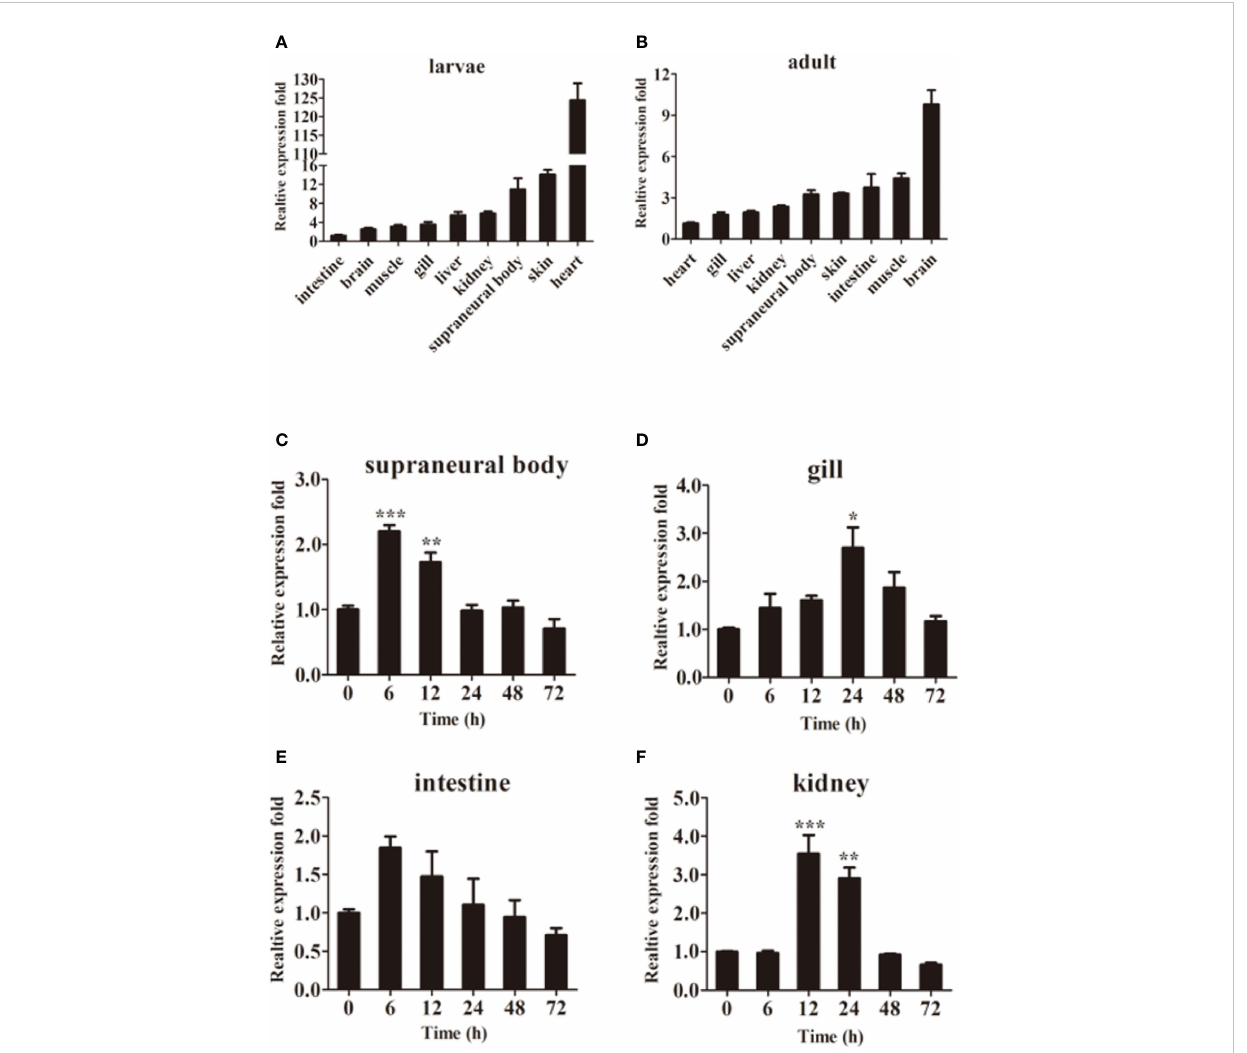
FIGURE 3 Tissue expression of LmTLR14d. Relative expression of LmTLR14d in different tissues of larvae (A) and adult (B) . LmTLR14d expression in adult SB (C) , gill (D) , intestine (E) , and kidney (F) challenged by P. aeruginosa at 0, 6, 12, 24, 48 and 72 h 2 - DD CT method was used to calculate the relative expression level. b -actin was used as an internal control for qPCR. Bars show mean ± SEM. A one-way ANOVA analysis of variance followed by the Bonferroni multiple comparison test. * means signi fi cant difference (n=3, * P <0.05 ** P <0.01 *** P